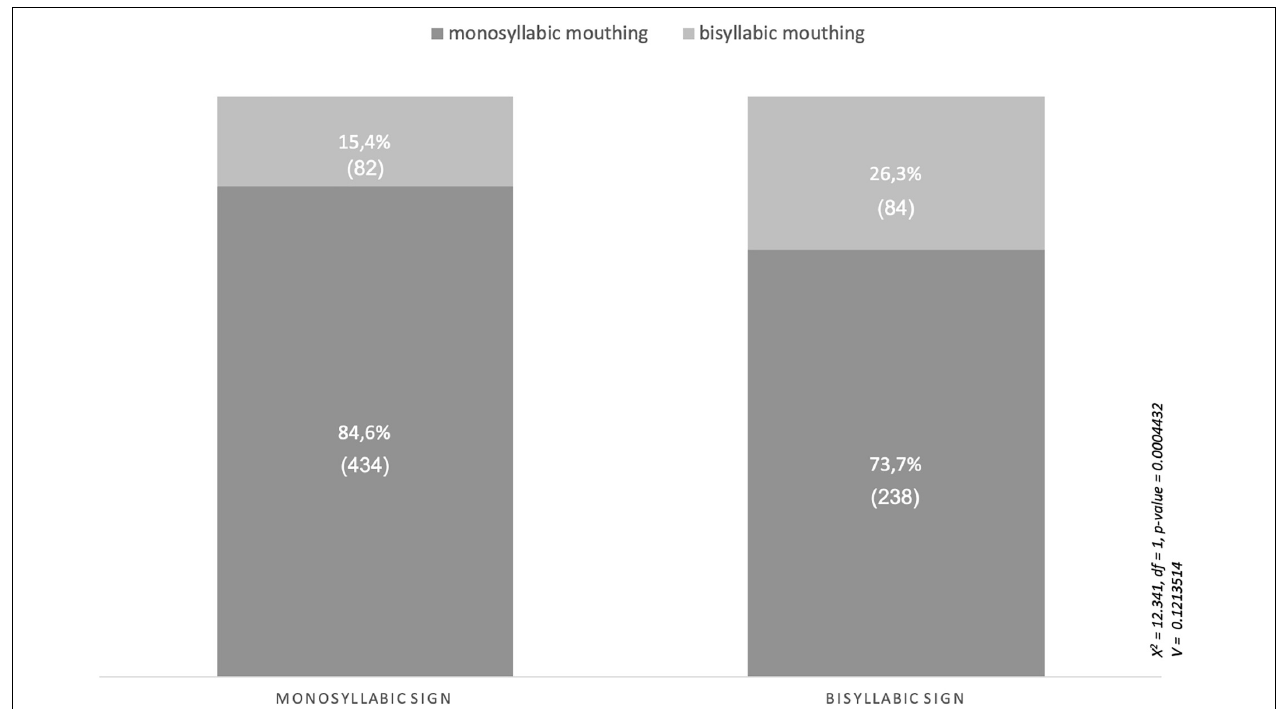
FIGURE 11 | The number of monosyllabic and disyllabic RSL signs corresponding to monosyllabic and disyllabic